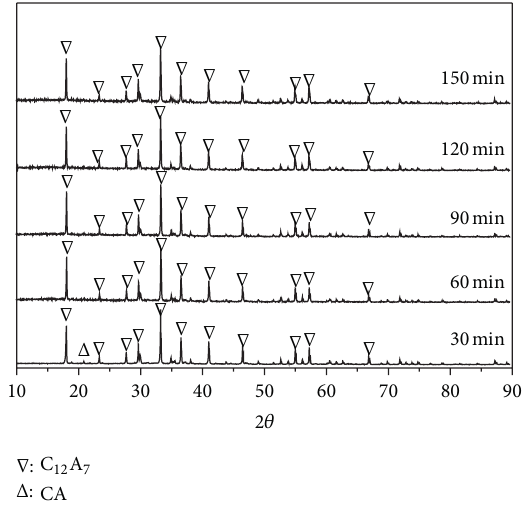
Figure 2: XRD pattern of samples synthesized at 1500 ∘ C with different holding